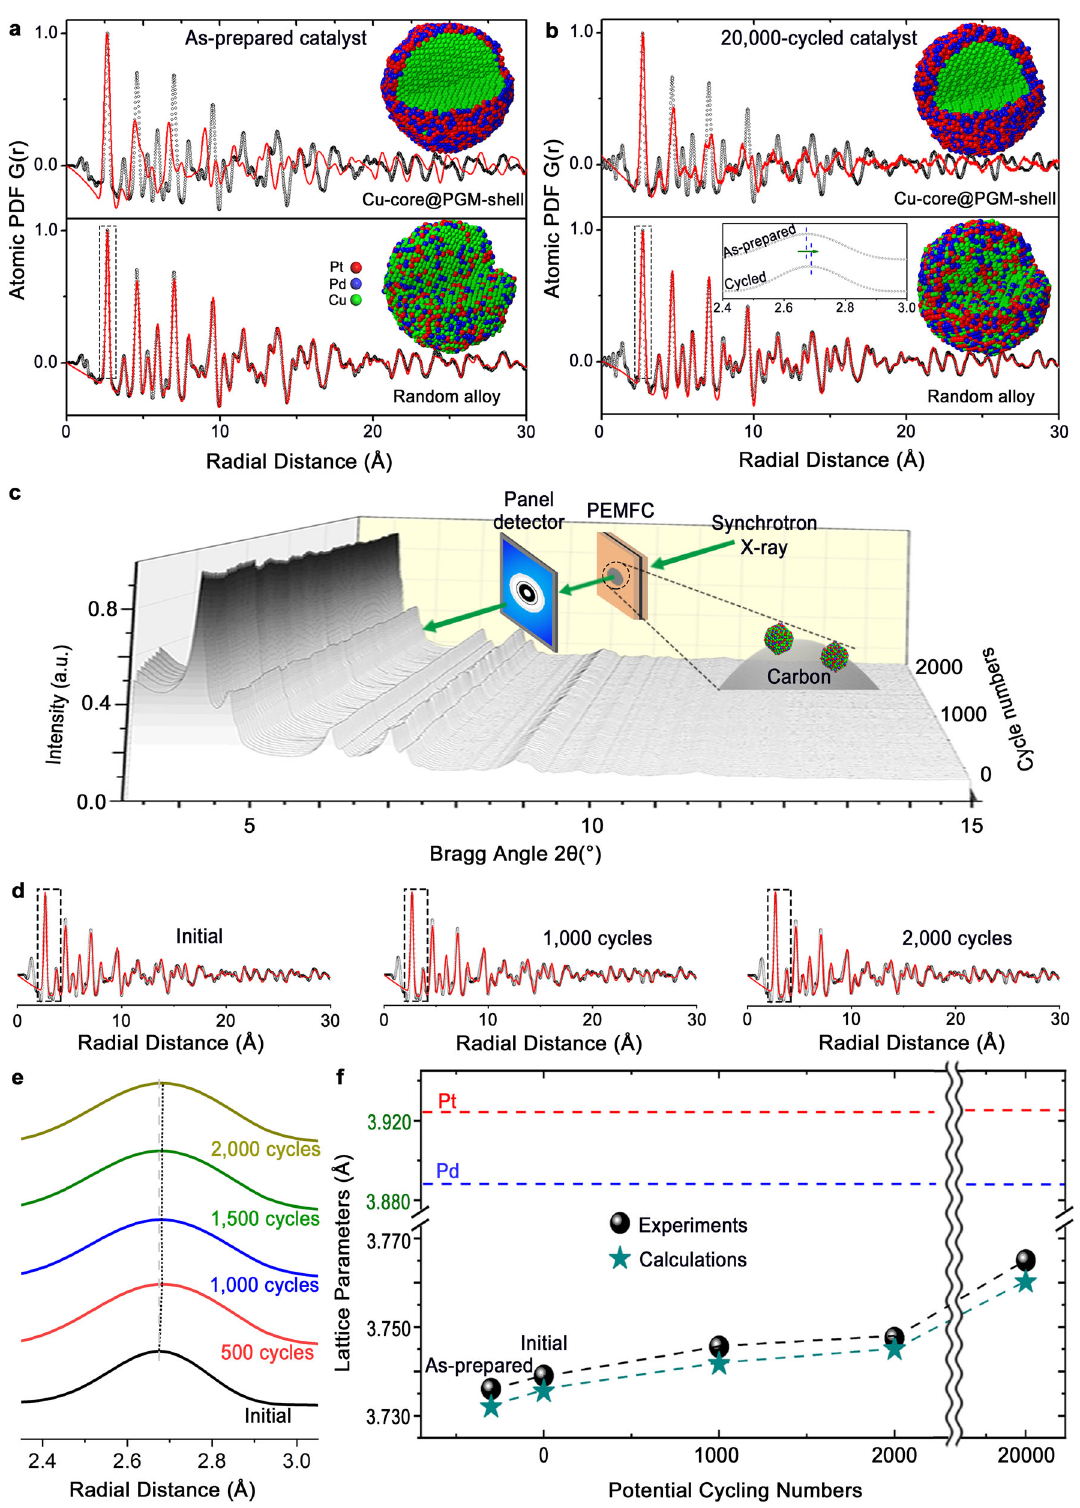
Fig. 4 The demonstration that the alloy catalyst remained in realloyed state during and after accelerated durability test (ADT) in standard electrochemical cell and in PEMFC (in-situ/operando). Experimental (black symbols) and RMC computed (red lines) atomic PDFs as well as the corresponding 3D RMC simulation models for a the as-prepared, and b the 20,000-cycled Pt 20 Pd 20 Cu 60 /C catalyst. Upper and bottom panels show RMC models and atomic PDFs for Cu-core@PGM-shell and random alloy structures, respectively. Inset in b ) is a magni fi ed view of the data in the dash box for the experimentally-obtained fi rst atomic PDF peak of as-prepared and cycled catalysts. c In operando HE-XRD patterns for Pt 20 Pd 20 Cu 60 /C catalyst inside an operating PEMFC upon potential cycles. d Experimental (black symbols) and model-computed (red lines) atomic PDFs for Pt 20 Pd 20 Cu 60 /C catalyst inside the PEMFC at 0, 1000, and 2000 cycles. e A close comparison of the experiment-obtained atomic PDFs at the low-r region (corresponding to the boxed regions in d ). f Plots of lattice parameters obtained from the experimental and the calculated PDFs as a function of the potential cycle